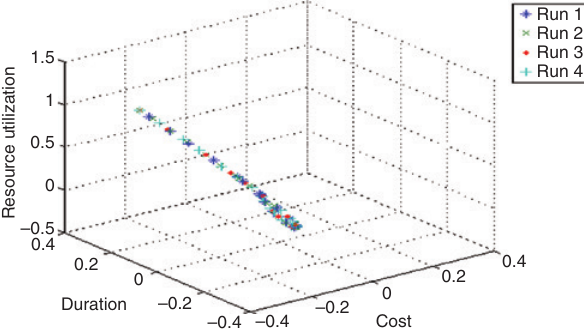
Figure 4: ENSES Resource Optimization Pareto Front of All